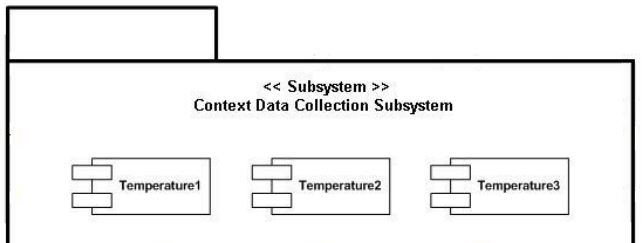
Figure 16. Context Data Collection subsystem and its inner